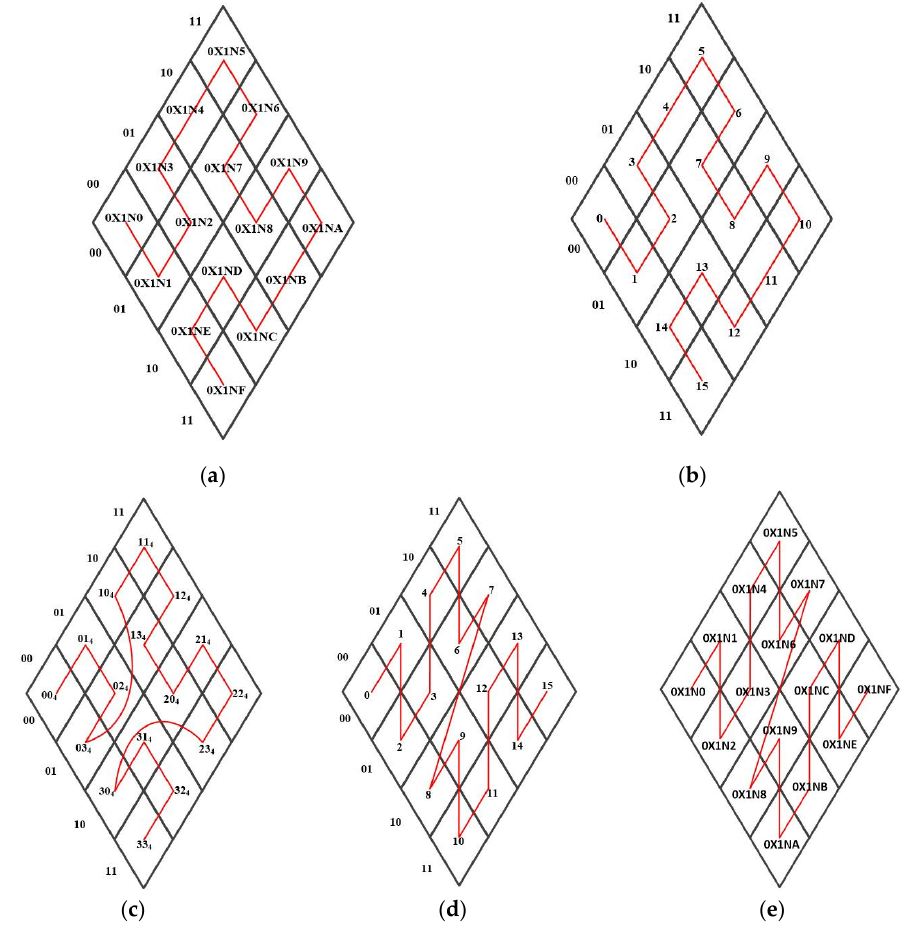
Figure 6. The process of converting DHC code to DZC code of the second level. ( a ) Second level DHC code; ( b ) Second level Hilbert curve; ( c ) 1 ‐ order Hilbert recursive curve; ( d ) Second level Z ‐ curve; ( e ) Second level DZC code.